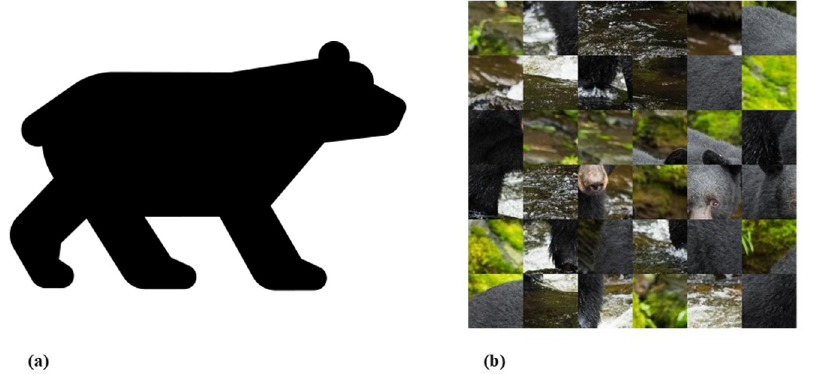
Fig 1. Demonstration of the importance of global shape in object recognition. (a) Silhouette of a bear; (b) Scrambled natural image of a bear (See text). Image URLs are in S2 File.